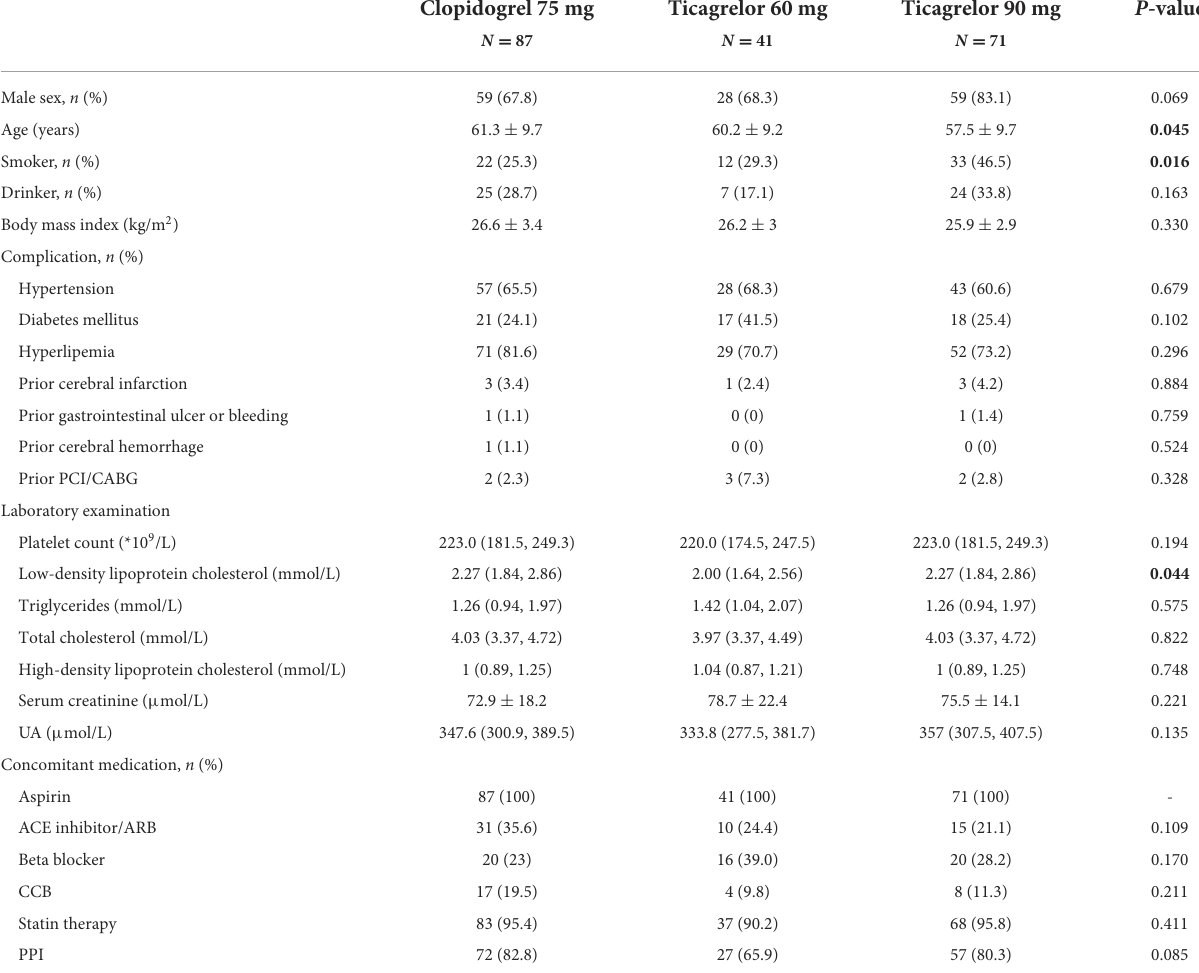
TABLE 1 Baseline demographic and clinical characteristics of included